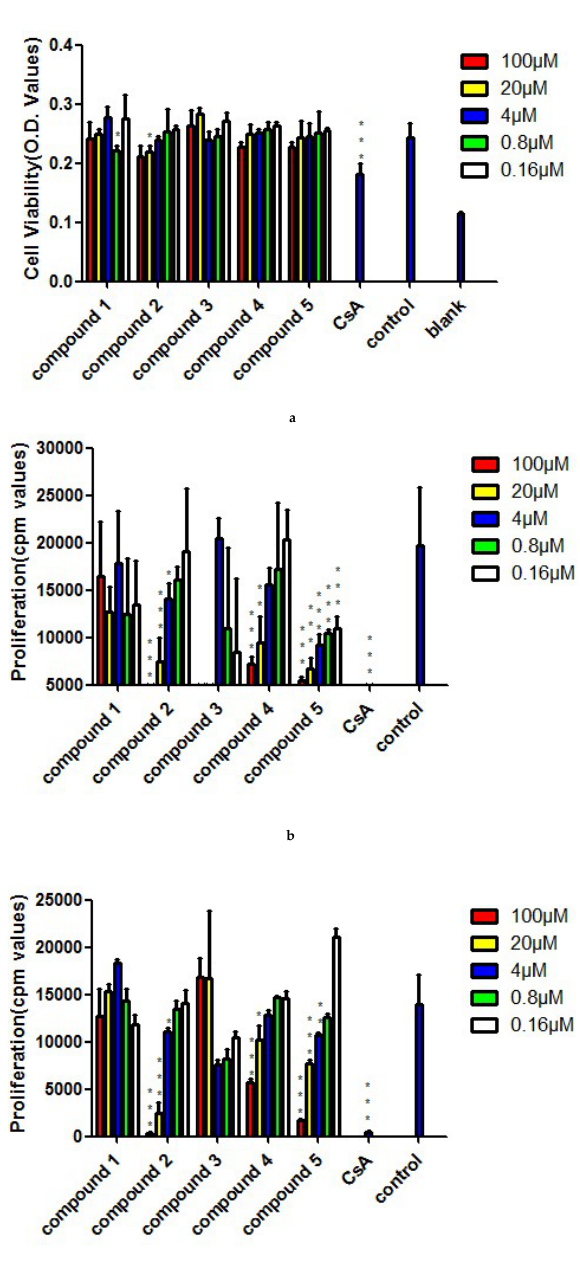
Figure 5. Cytotoxicity on splenocytes and inhibition on ConA- or LPS-induced splenocyte proliferation of Compounds 1 – 5 . ( a ) Cytotoxicity of Compounds 1 – 5 on BALB/c mice splenocytes. ( b ) Inhibition of Compounds 1 – 5 on ConA-induced splenocyte proliferation. ( c ) Inhibition of Compounds 1 – 5 on LPS-induced splenocyte proliferation. Results are mean ± S.D. * p < 0.05, ** p < 0.01, *** p < 0.001, treatment group versus control.